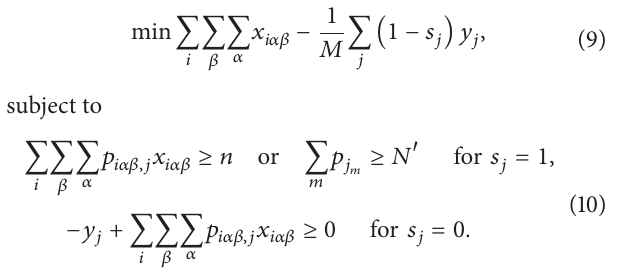
essential regions and as many ordinary regions as